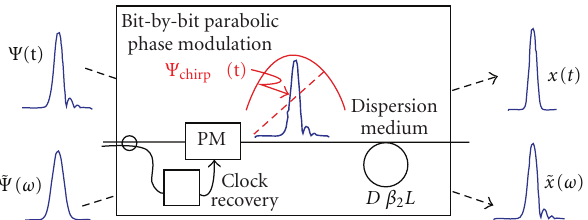
Figure 6: Schematic diagram of time-domain OFT (after [90]).